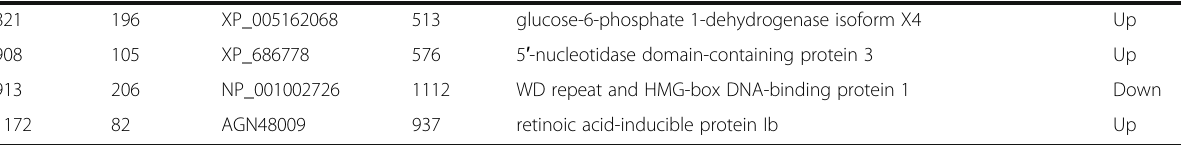
Table 4 Protein comparison of MS identification results between oridonin groups (a, b, c) and control groups (1,2,3) (Continued)